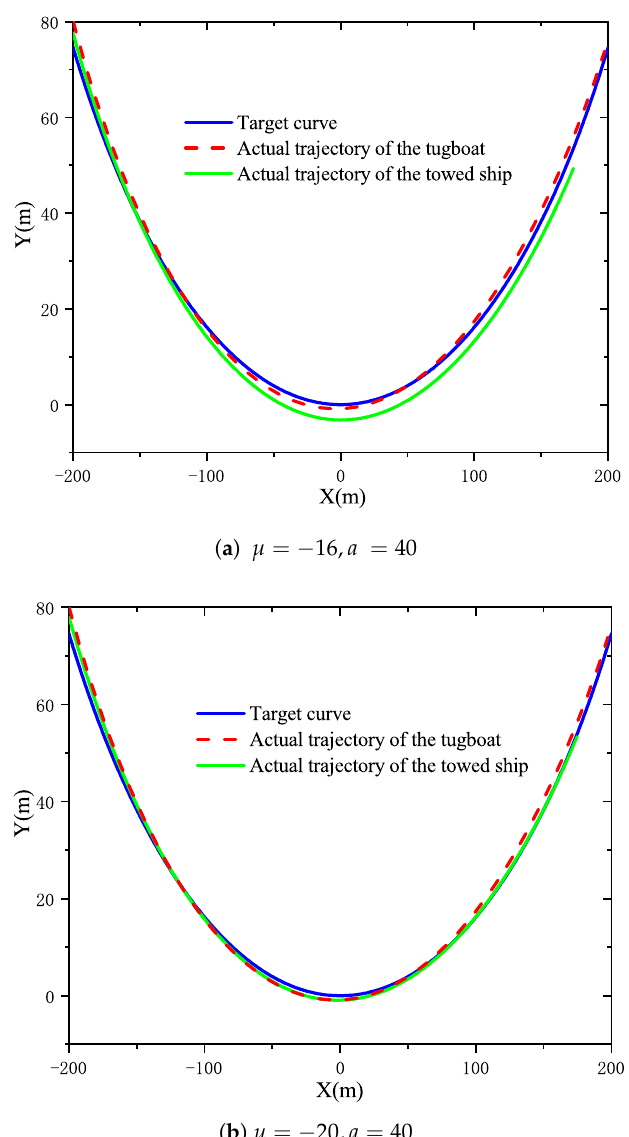
Figure 6. Comparison of actual motion trajectories of the towed ship between different steering